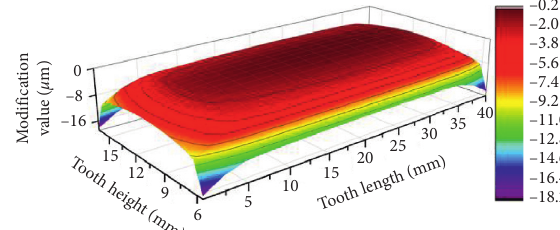
Figure 25: Modification of the output-stage pinion.